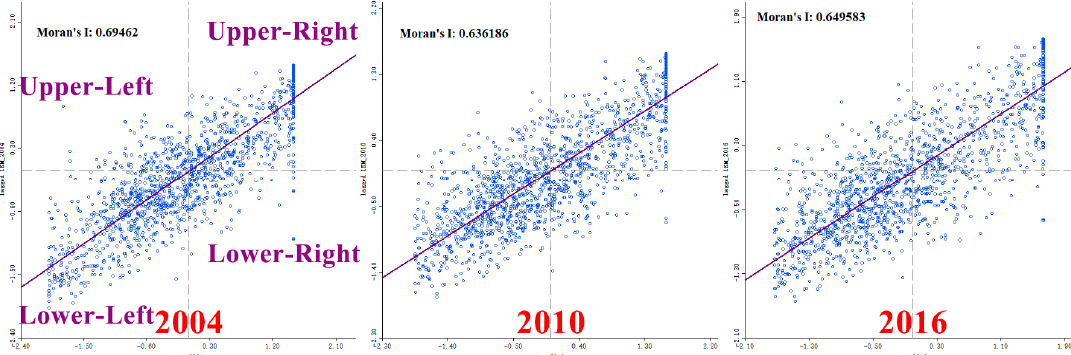
Figure 6. ESD scatter plot . In this study, a local spatial autocorrelation analysis agglomeration map